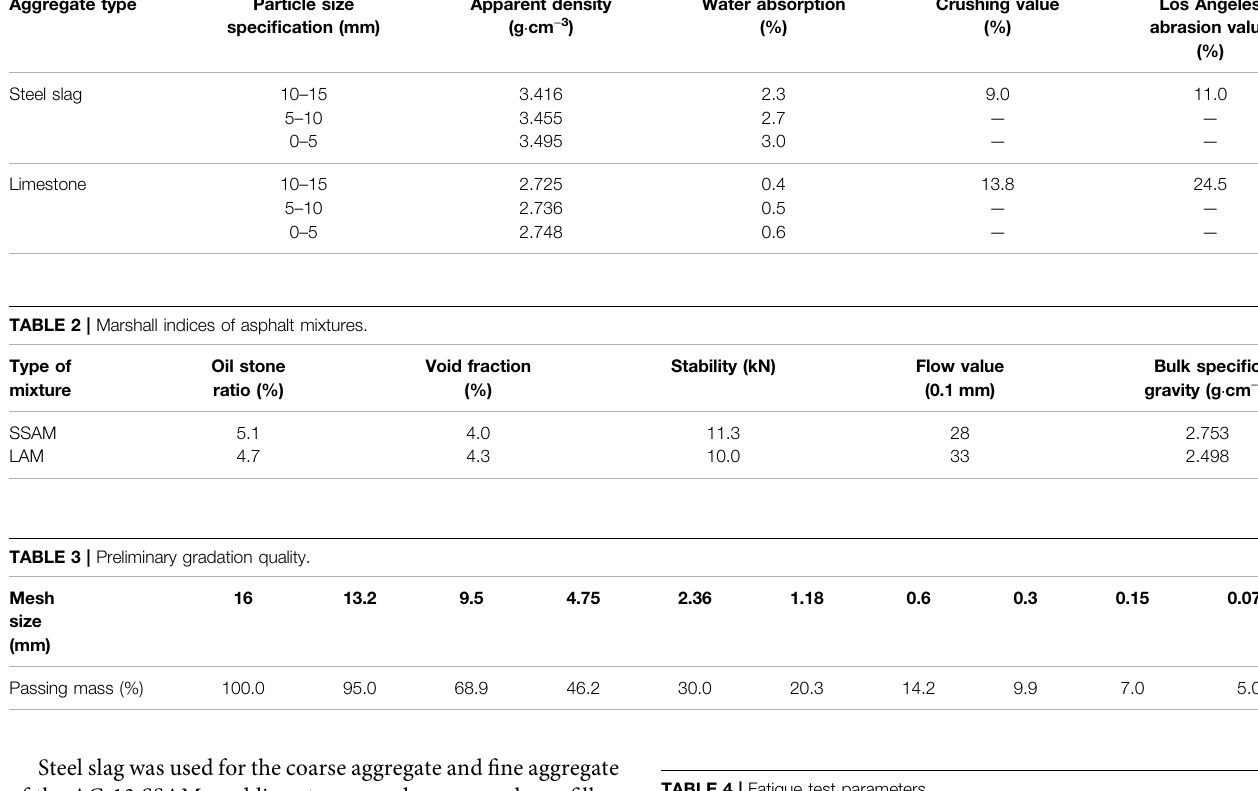
TABLE 4 | Fatigue test